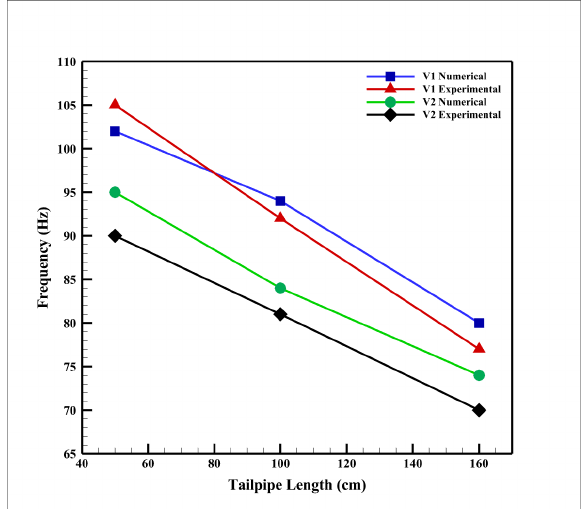
Fig. 4. Variation of the frequency with the tailpipe length for V1 and V2 a higher heat release